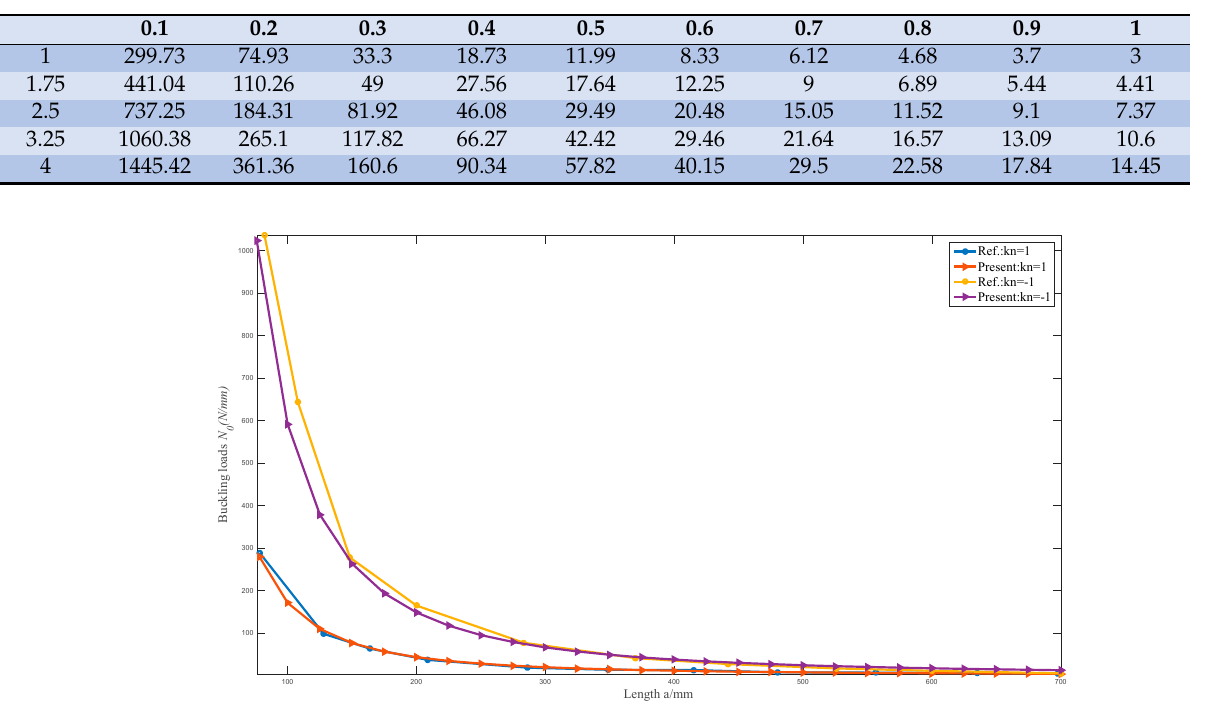
Figure 12. Validation. Figure 12.